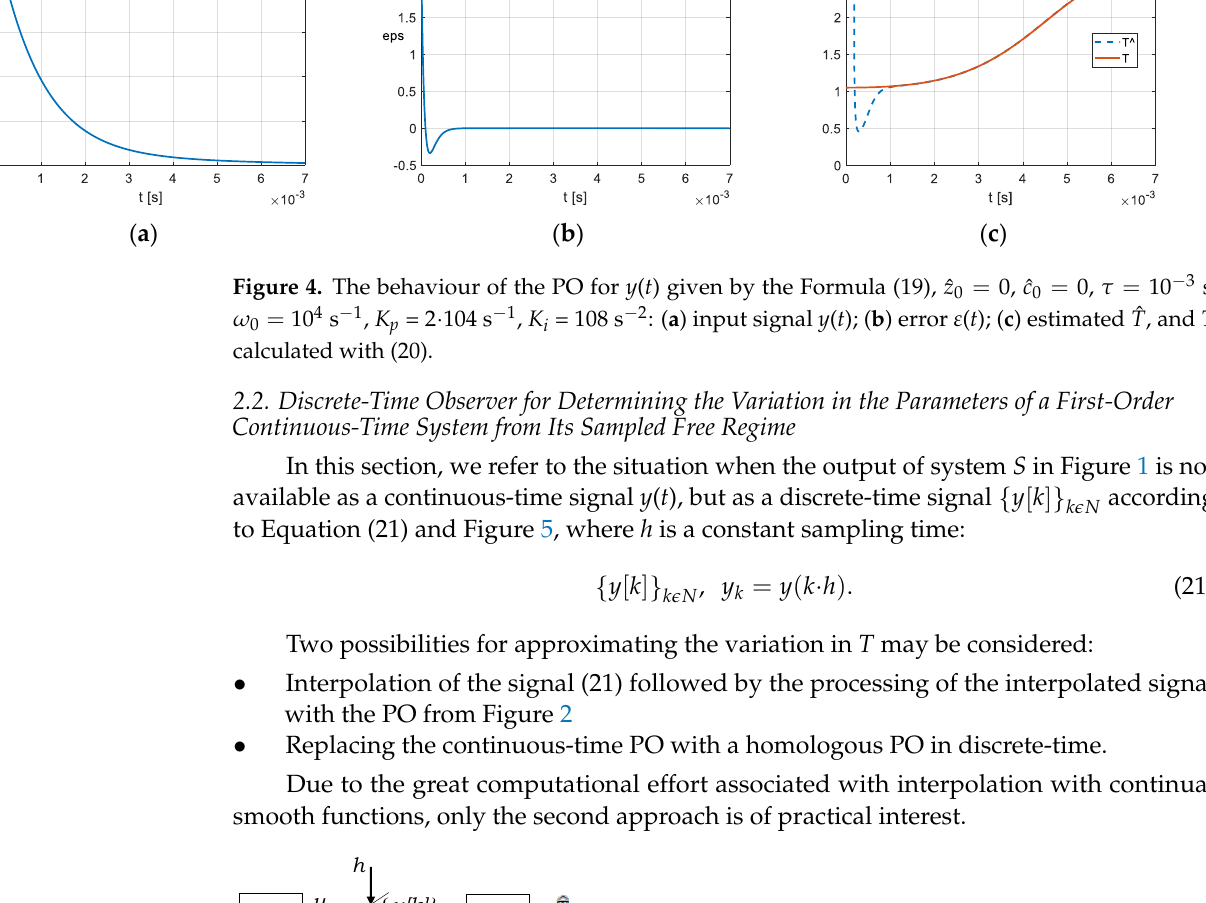
Figure 5. The block diagram of the observation of the parameter T .